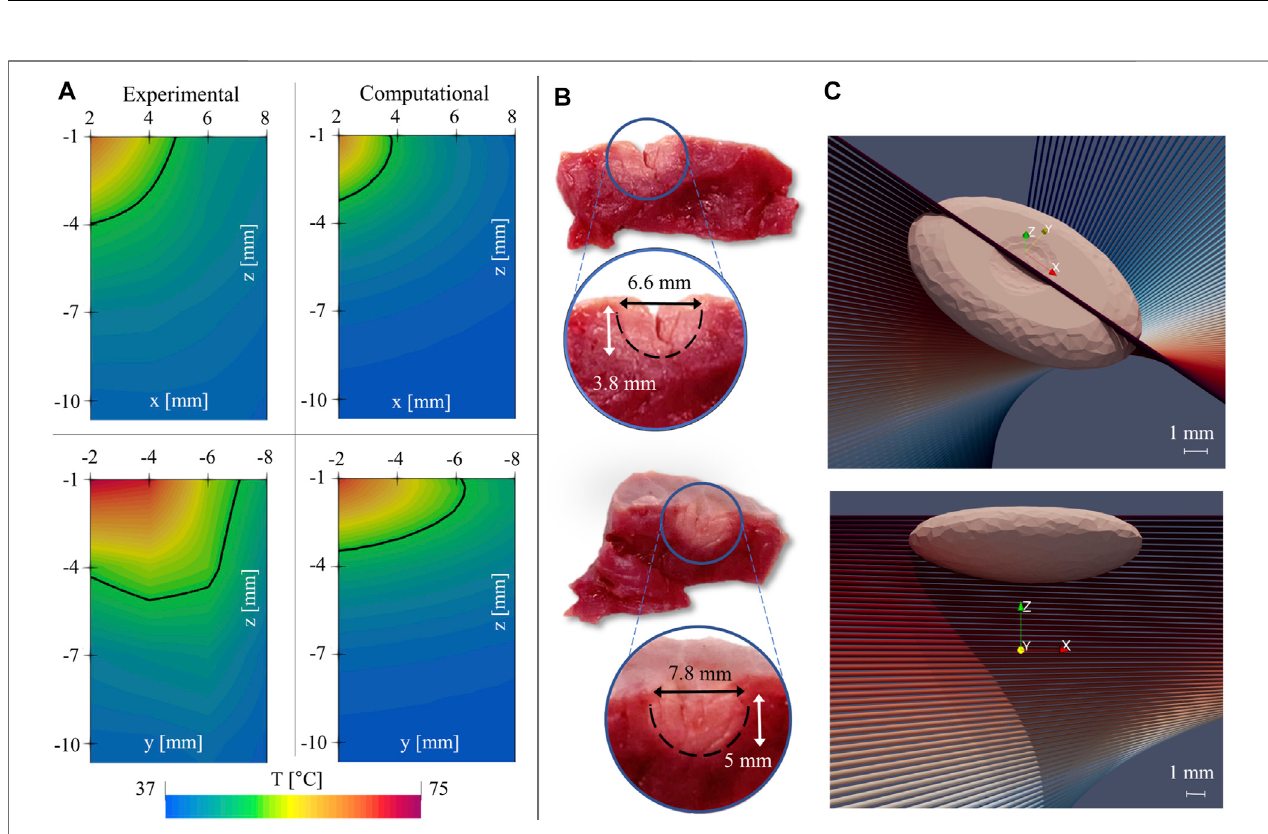
FIGURE 7 | (A) comparison of experimental (left) and computational (right) temperature maps, revealing different elongations of the thermal lesion across orthogonaldirections. (B) Half-sectionsofthetissueafterRFAtreatment,slicedatthelesionsite,alongtheplaneoftheFBGs ’ arrays. (C) 3Dviewsofthenumericallesion resulting from the calibrated